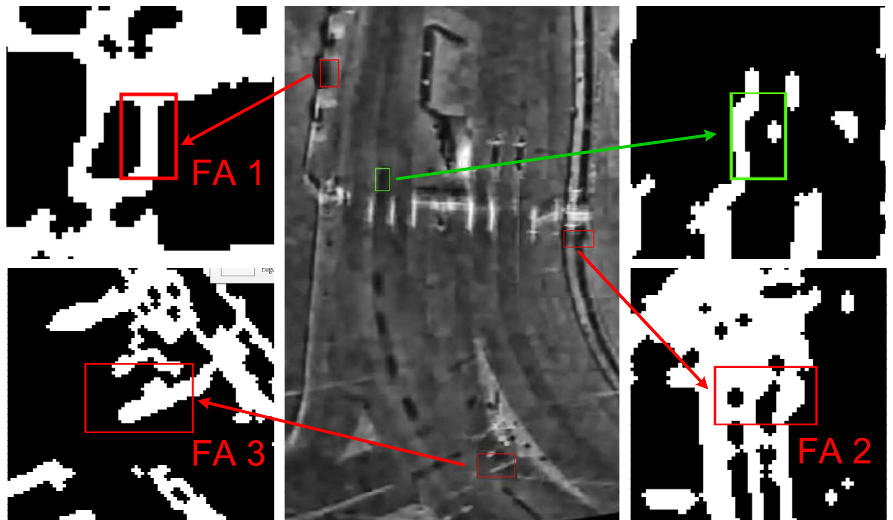
Figure 3. Schematic diagram of the false alarms in the edge region. Green rectangles indicate the shadow area of moving targets and red ones indicate some common kinds of false alarms in edge region. Their corresponding edge regions (same detection parameters) are zoomed in for better